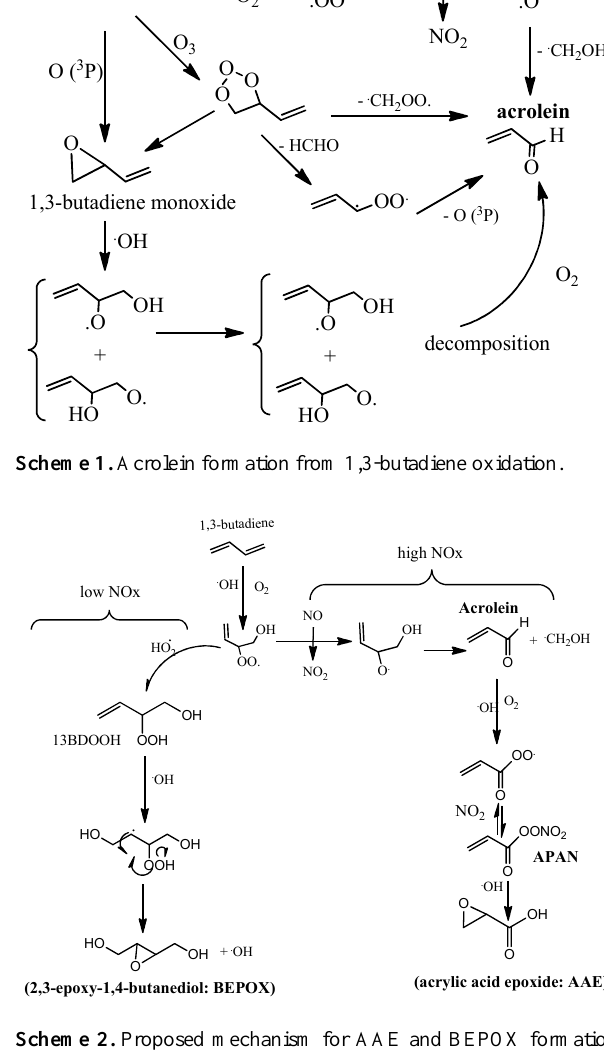
Scheme 2. Proposed mechanism for AAE and BEPOX formation from 1,3-butadiene oxidation